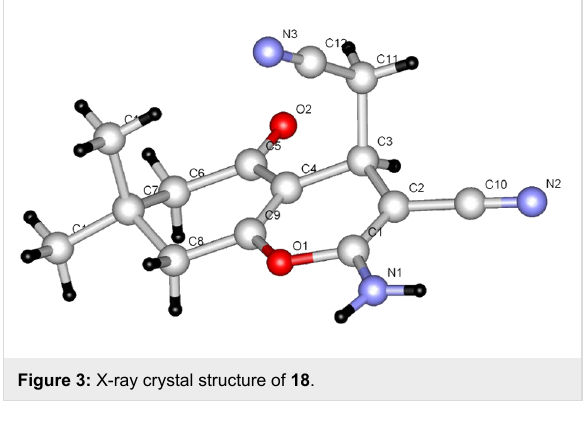
Figure 3: X-ray crystal structure of 18 .